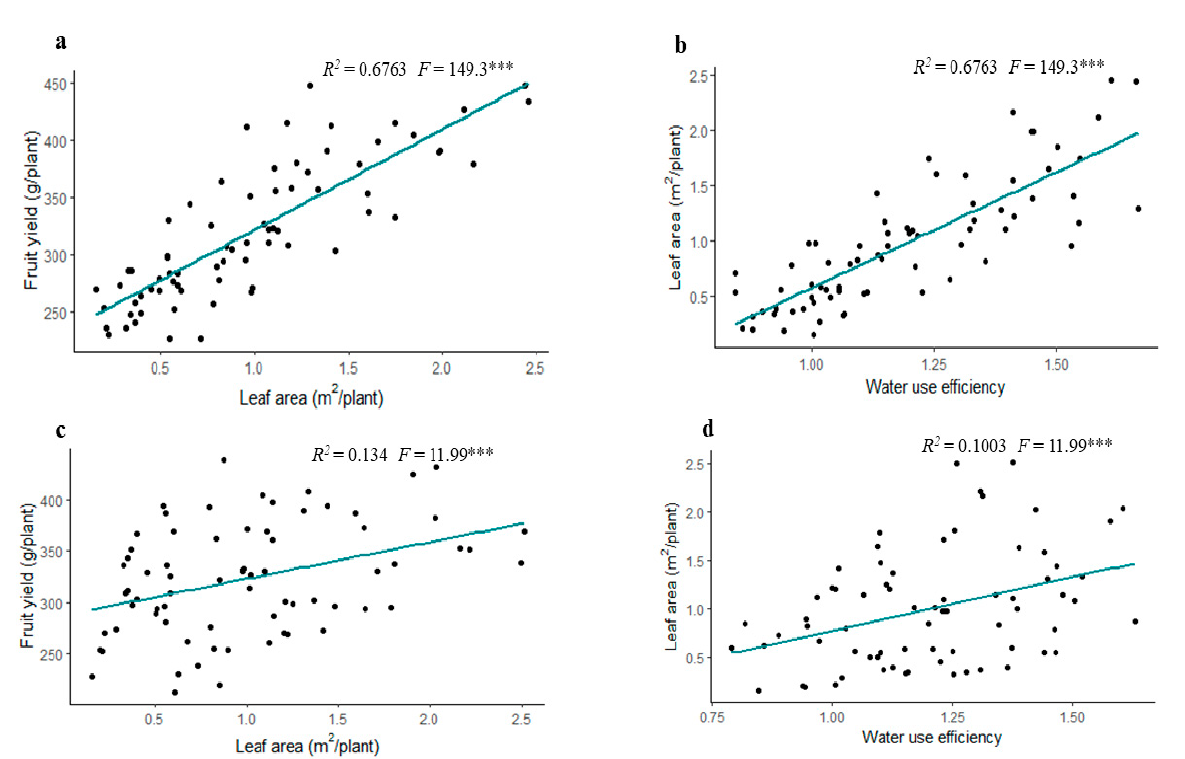
Figure 8. Regression plots showing the linear relationship between fruit yield (fresh weight) and leaf area in ( a ) 2020 and ( c ) 2021 and leaf area with water-use efficiency in ( b ) 2020 and ( d ) 2021. R 2 , regression coefficient of determination; F, calculated F-statistic value; ***, Significant at p ≤ 0.001.